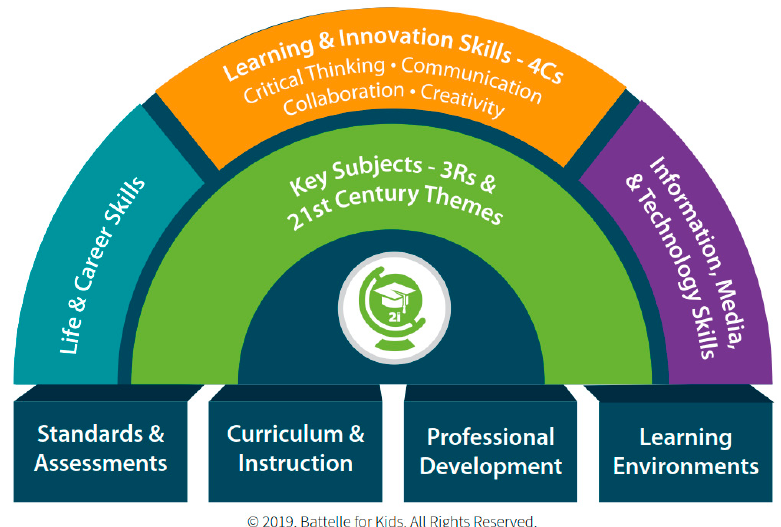
Figure 1. The P21 Framework for 21st Century Learning. (© 2019, Battelle for Kids. All Rights Reserved. https://www.battelleforkids.org/; accessed on 17 January 2023).